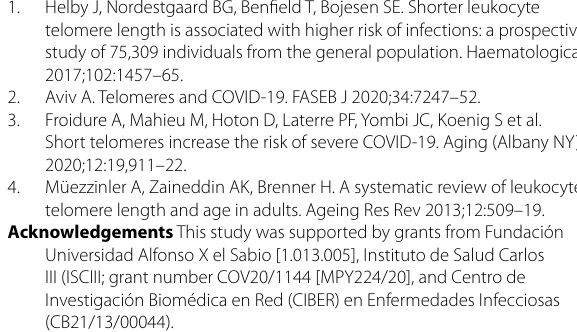
Conclusion: In this study, RTL was not associated with the survival of patients with COVID-19, nor with other variables. Despite exclusively including critically ill patients, the low mortality of this series could have influenced these